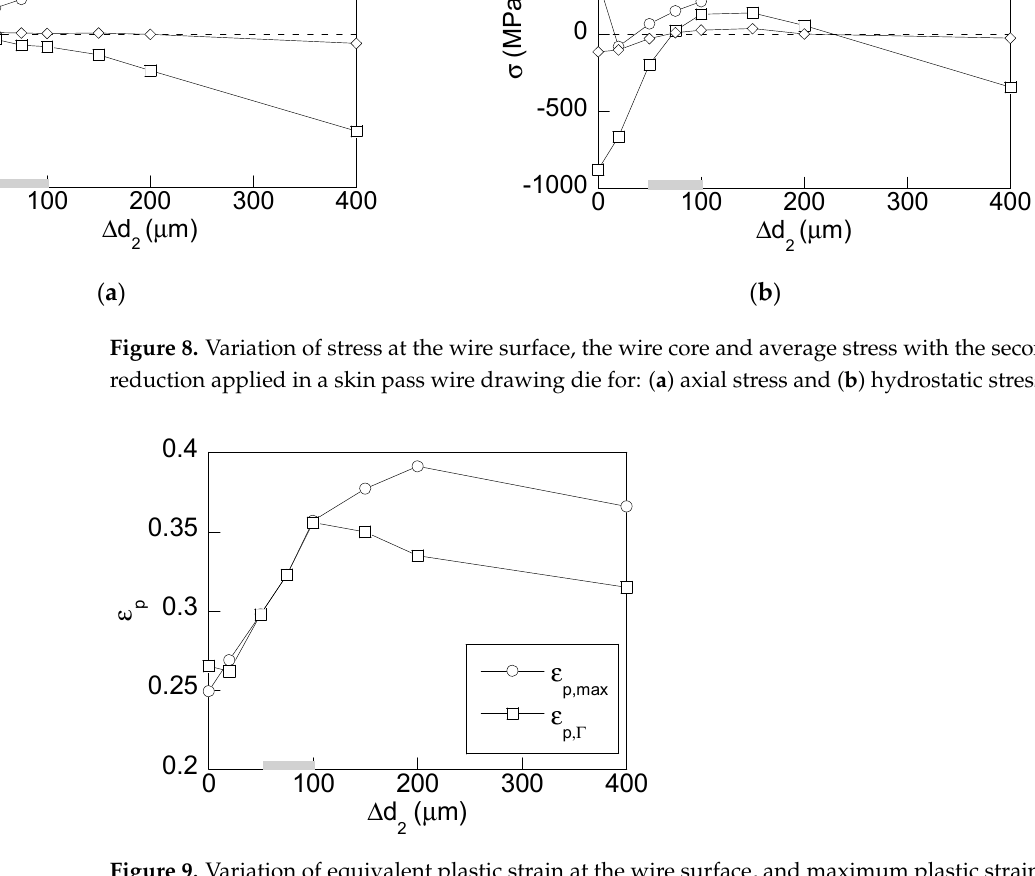
Figure 9. Variation of equivalent plastic strain at the wire surface, and maximum plastic strain with the secondary reduction applied in a skin pass wire drawing die.